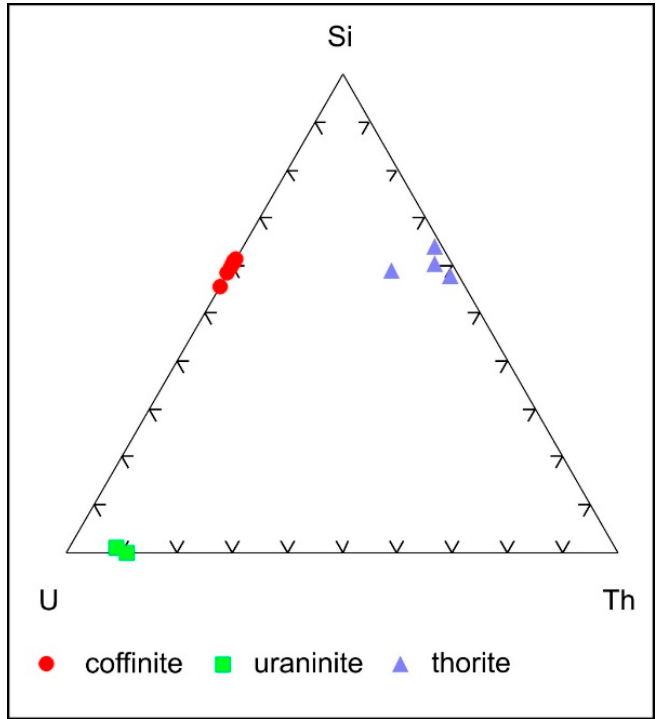
Figure 11. Composition of coffinite, uraninite, and thorite from the Nahošín and Me č ichov uranium deposits. Table 2. Representative analyses of uranium and thorium minerals (wt